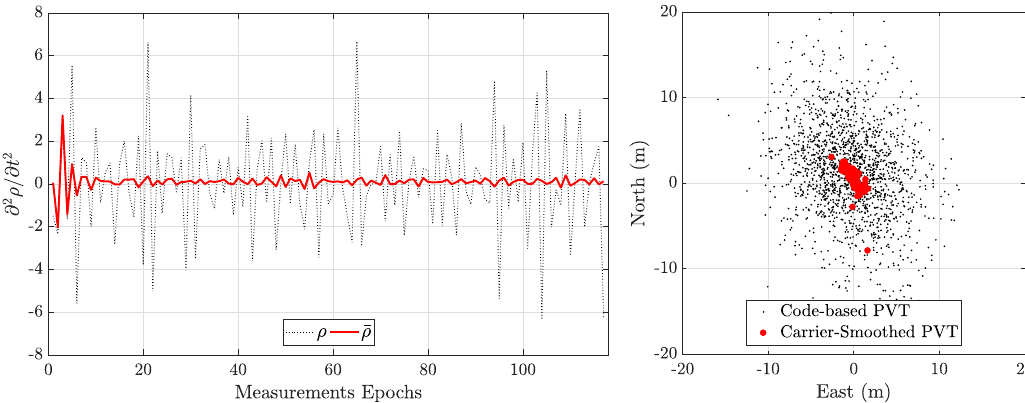
Figure 5. Example of second order derivative of the raw and carrier-smoothed pseudorange measurements for a single Global Positioning System (GPS) satellite and related positioning